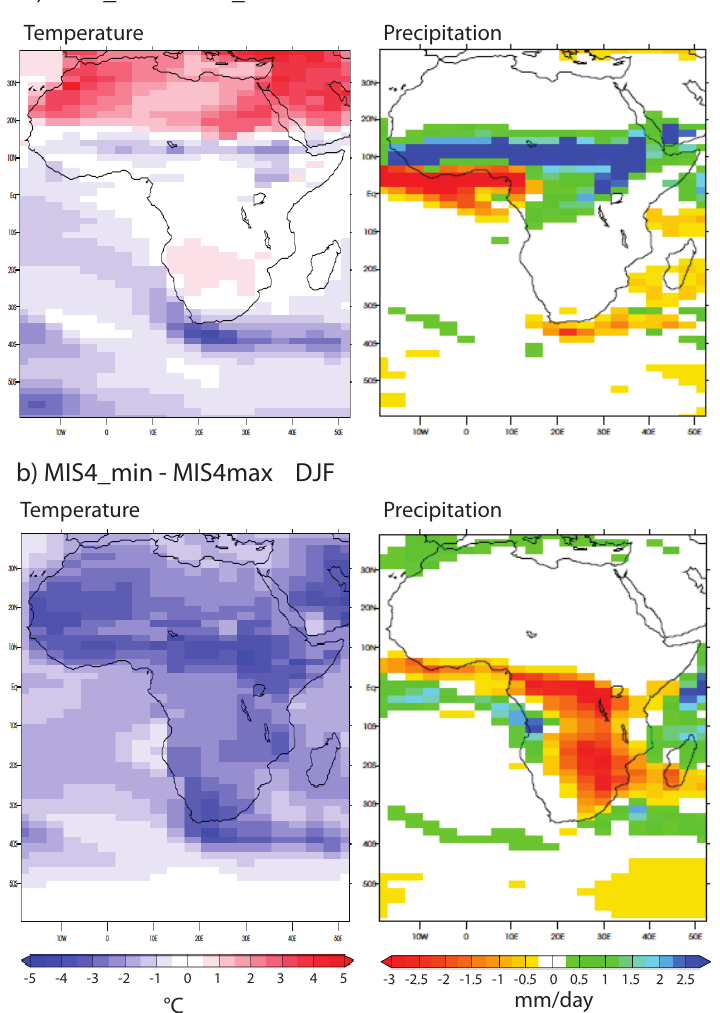
Figure 7. Difference in mean temperature ( ◦ C) and mean precipitation (mmday − 1 ) simulated with IPSL_CM5A between the beginning and end of MIS4 (MIS4_min–MIS4_max). (a) Average for the boreal summer months (June–August); (b) average for the boreal winter months